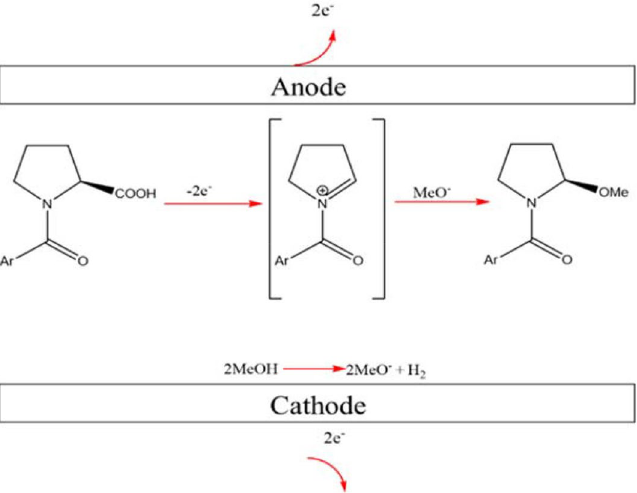
Figure 5. Schematic illustration of the Shono oxidation proceeding within the short interelectrode distance of the